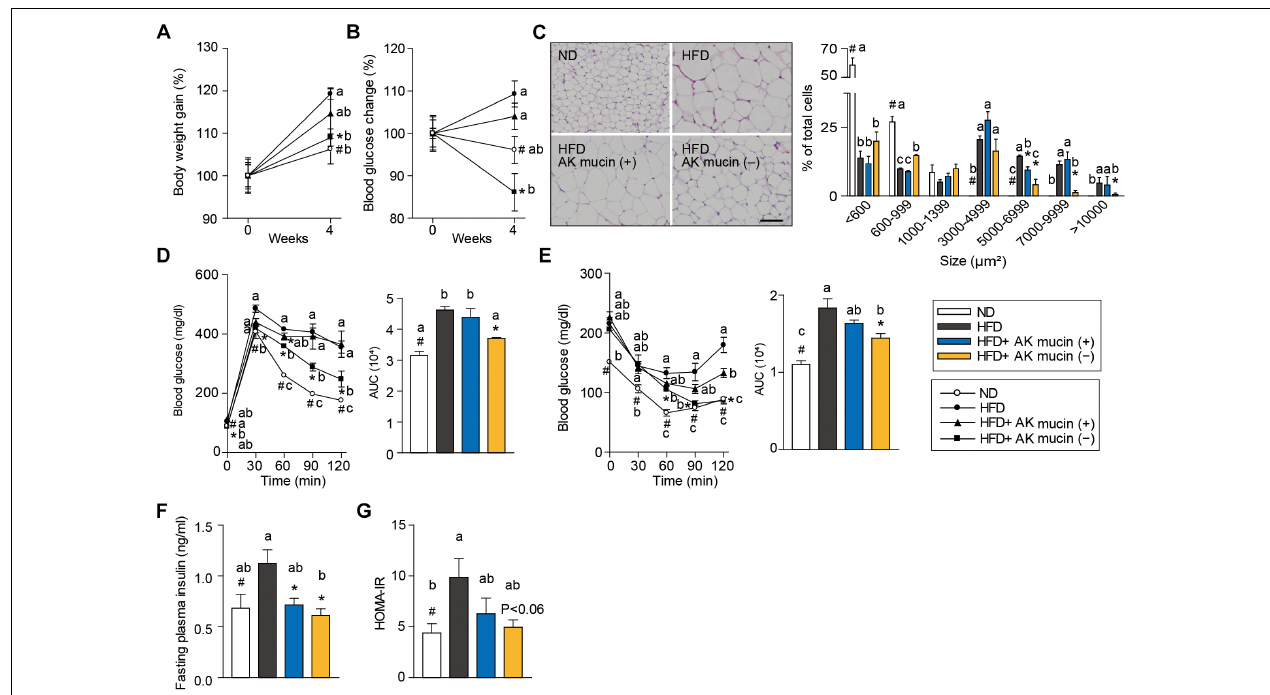
FIGURE 4 | Effects of A. muciniphila on HFD-induced obesity. (A) Body weight and (B) blood glucose change (%) after 4 weeks of treatment. (C) Representative H&E-stained images and size distribution of epididymal adipose tissue deposits. Scale bars, 100 µ m. (D) Blood glucose change and the mean area under the curve (AUC) measured during the IP-GTT. (E) Blood glucose change and the mean area under the curve (AUC) measured during the IP-ITT. (F) Fasting plasma insulin and (G) HOMA-IR index measured after 4 weeks of treatment. Data are means ± SEM ( n = 4–5 for each group). # P < 0.05, High fat diet (HFD) vs. Normal chow diet (ND) group, ∗ P < 0.05, HFD vs. A. muciniphila -treated group (two-tailed Student’s t -test). abc Means not sharing a common letter are significantly different at P < 0.05 (Tukey-Kramer HSD